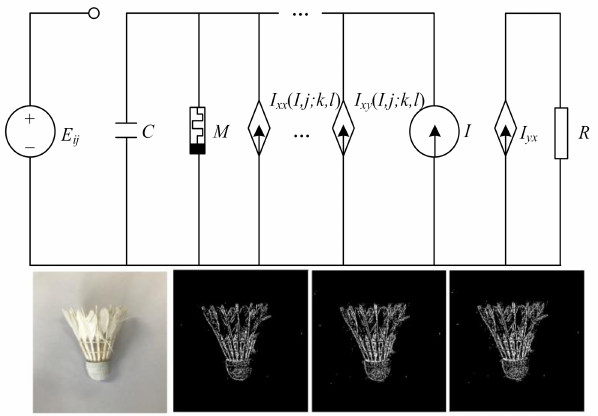
Figure 17. Memristor-based cell neural network.